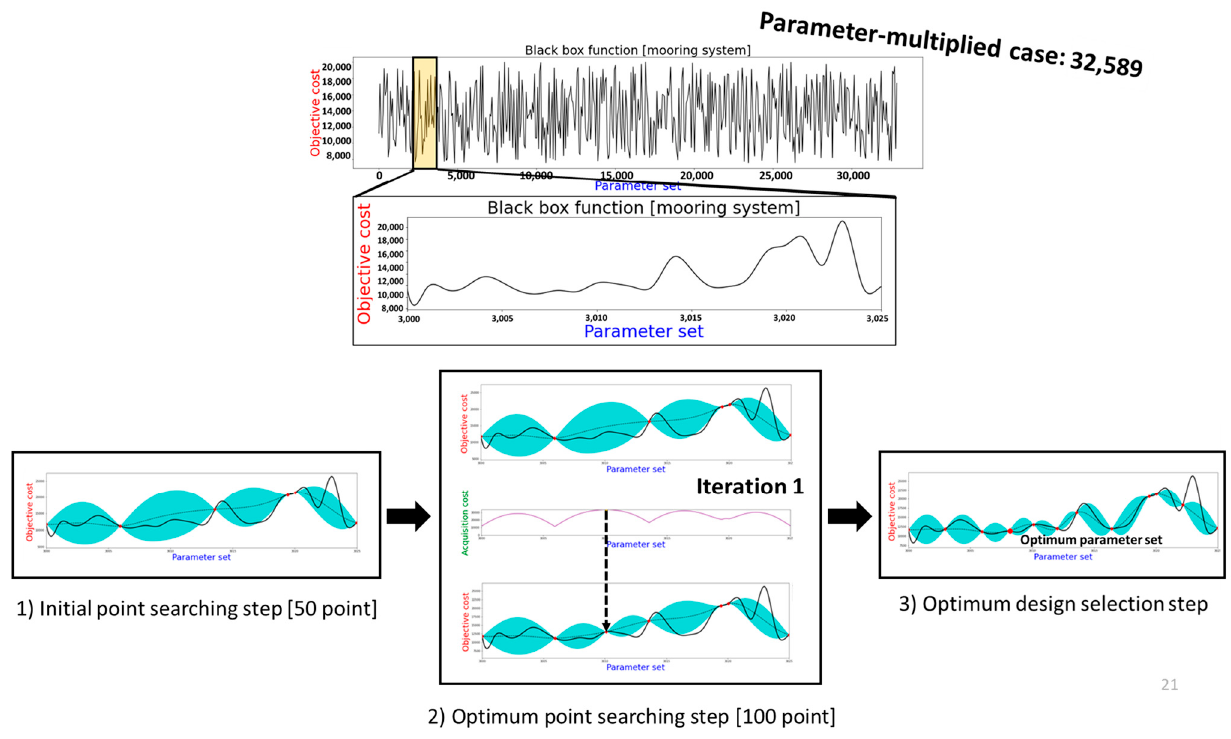
Figure 7. Example of procedure of BOA.